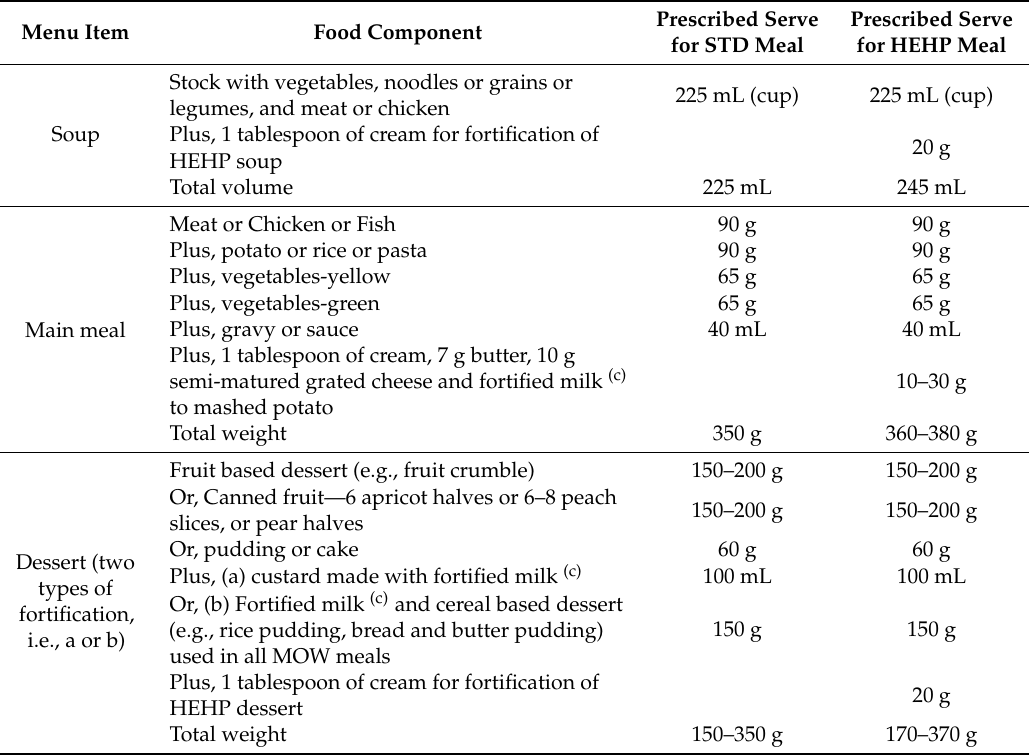
Table 1. Food components and the prescribed serve size for each menu item within the Standard and High Energy and Protein fortified meals (a),(b)